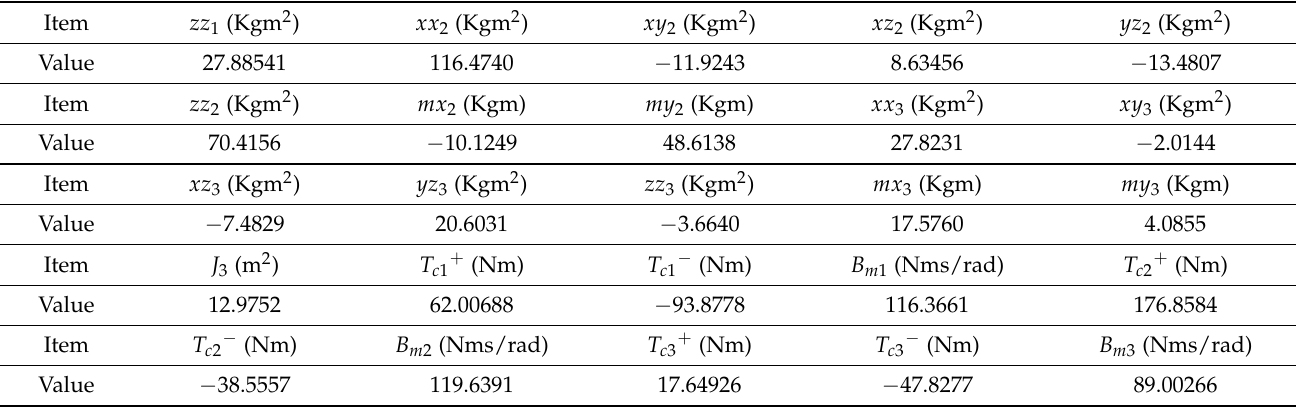
Figure 6. Measured and calculated joint-driving torque values. Table 2. Base dynamic parameters of the